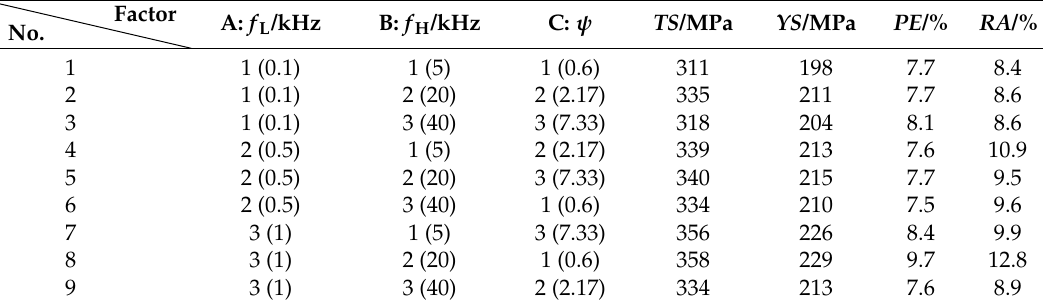
Table 4. Tensile properties of AA 5456 Al alloy welded joints by orthogonal